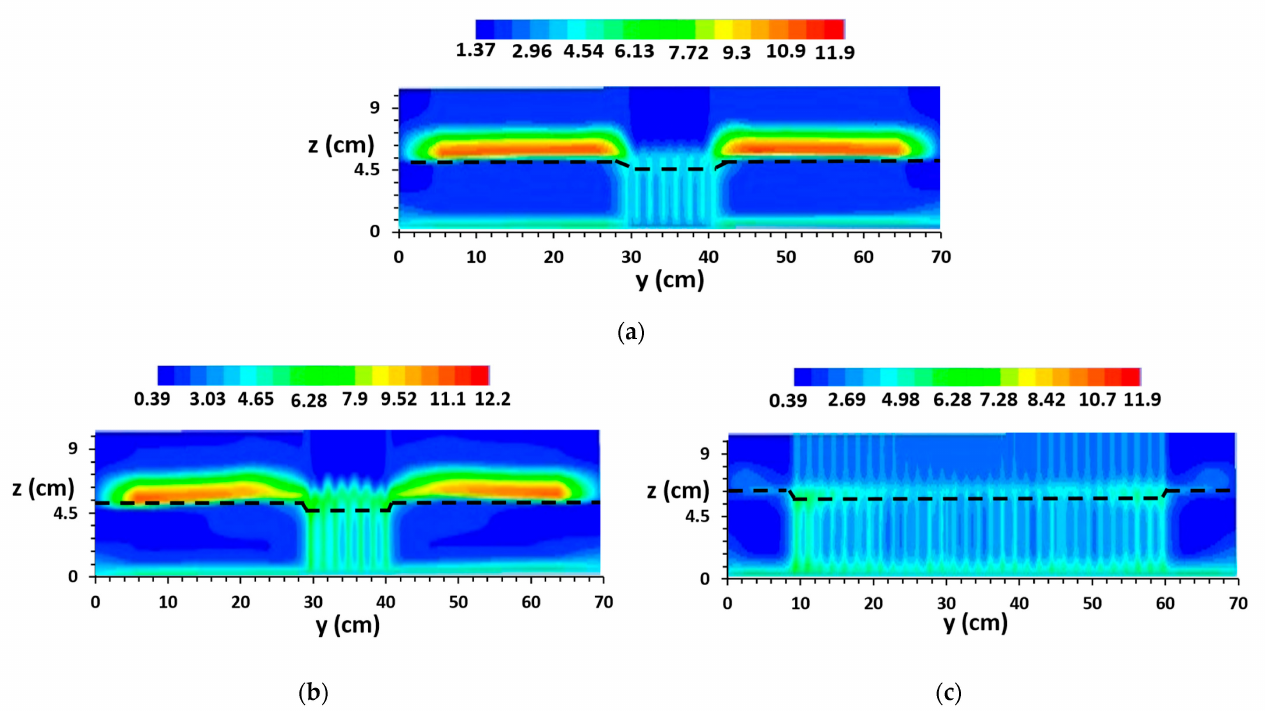
Figure 14. Turbulent intensities (%) along the cross-section CS1 ( a ) Case 1; ( b ) Case 3 and ( c ) Case 5. Savelsberg and Van de water [51] found that turbulence of air at the free surface indicates air entrainment into the water region. Above the FSL, in the gap region, strong air turbulent intensity was observed in case (1), 11.9%, and case (3), 12.1%, indicating strong air entrainment over this region, Figure 14a,b. In the gap region of the maximum AR case (5), less than 3% of air turbulent intensity was gained over the free surface level due to constriction of the gap area. while a significant increase in air turbulent intensity above the vegetation region was found in case (5), i.e., wider vegetation patch, Figure